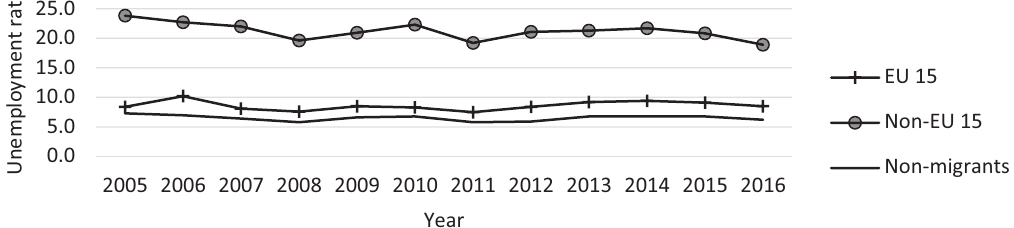
Figure 1. Unemployment rate by origin group, Belgium, 2005–2017. Note: EU 15 includes Austria, Denmark, Finland, France, Germany, Greece, Ireland, Italy, Luxembourg, the Netherlands, Portugal, Spain, Sweden, and the United Kingdom. Source: Eurostat